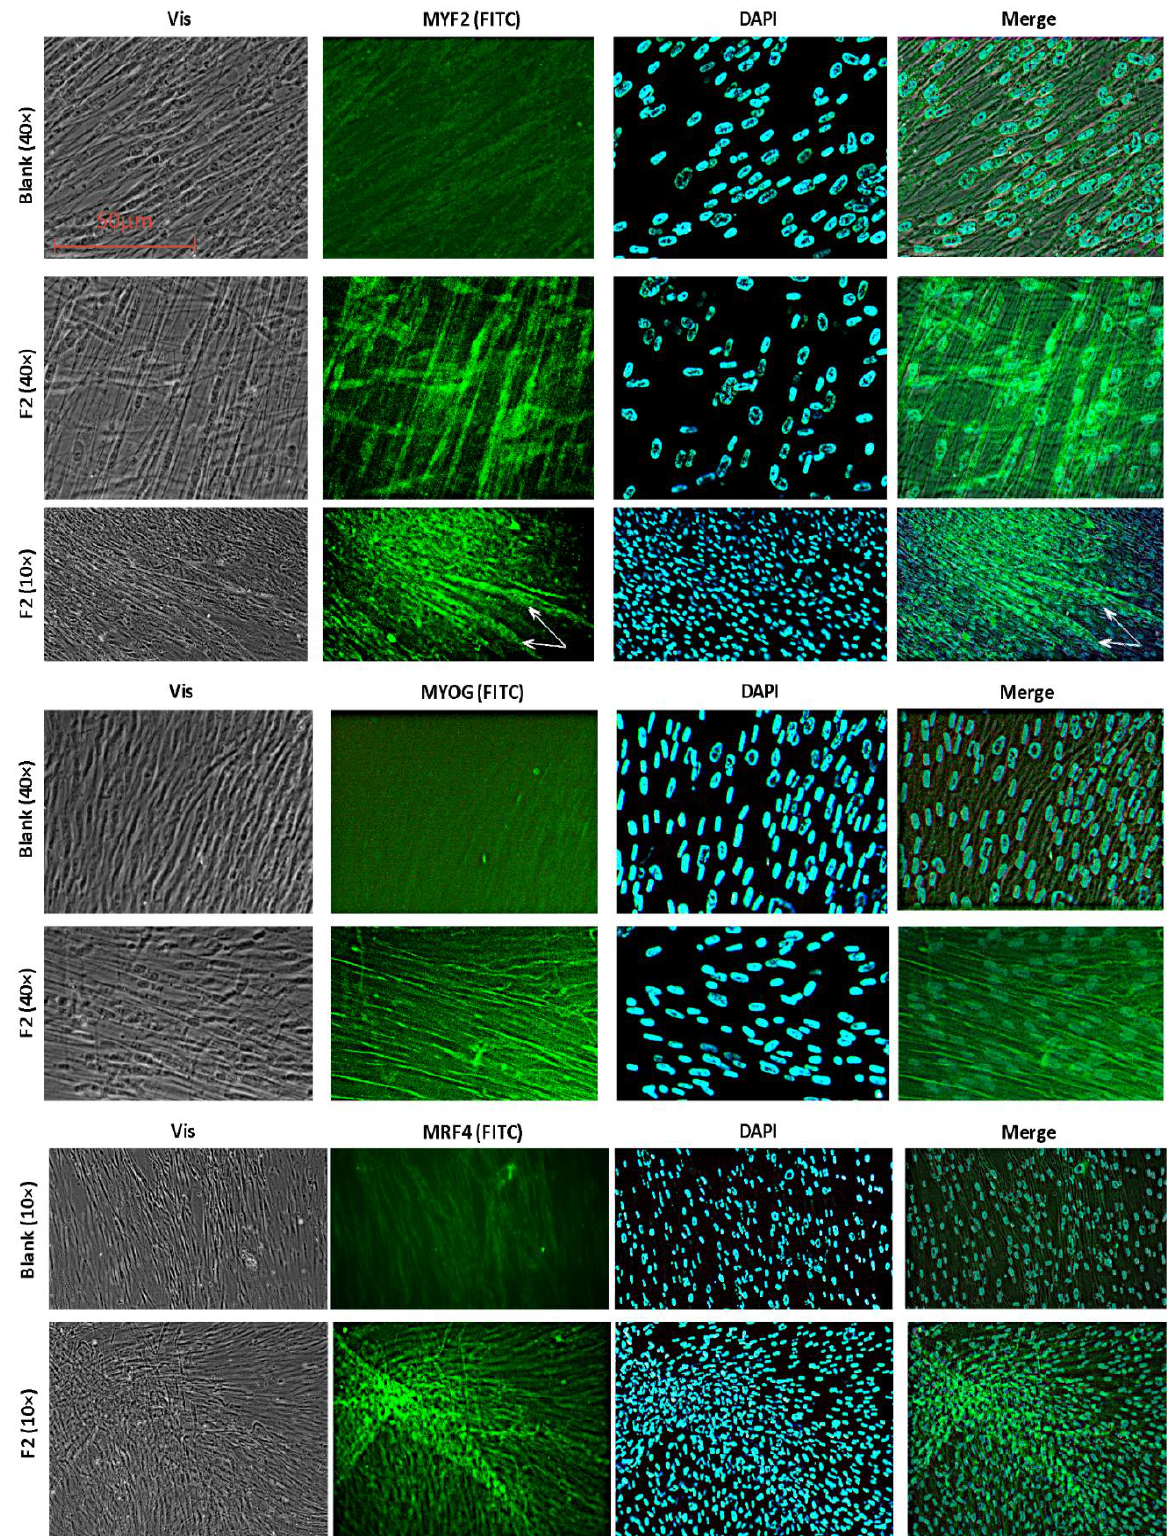
Figure 8. Expression and distribution of the transcription factors of myogenic differentiation 14 days after exposure to fullerene F2 (195 μM). Fluorescence microscopy, 40×, from left to right: visible light, fluorescence image of cells treated with antibodies to the proteins, DAPI staining of nuclei, a merged photo, merged fluorescence, and a transmitted light brightfield images photo.